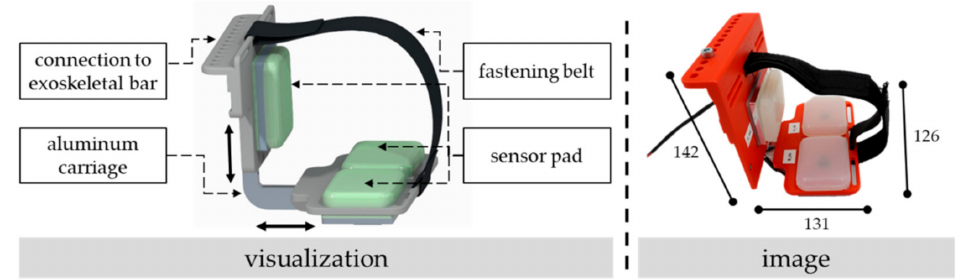
Figure 2. Visualization ( left ) and image ( right ) of the constructed exoskeletal interface with embedded force sensors and the ability to adjust the size with prepared holes in the aluminum carriage. The dimensions are given in